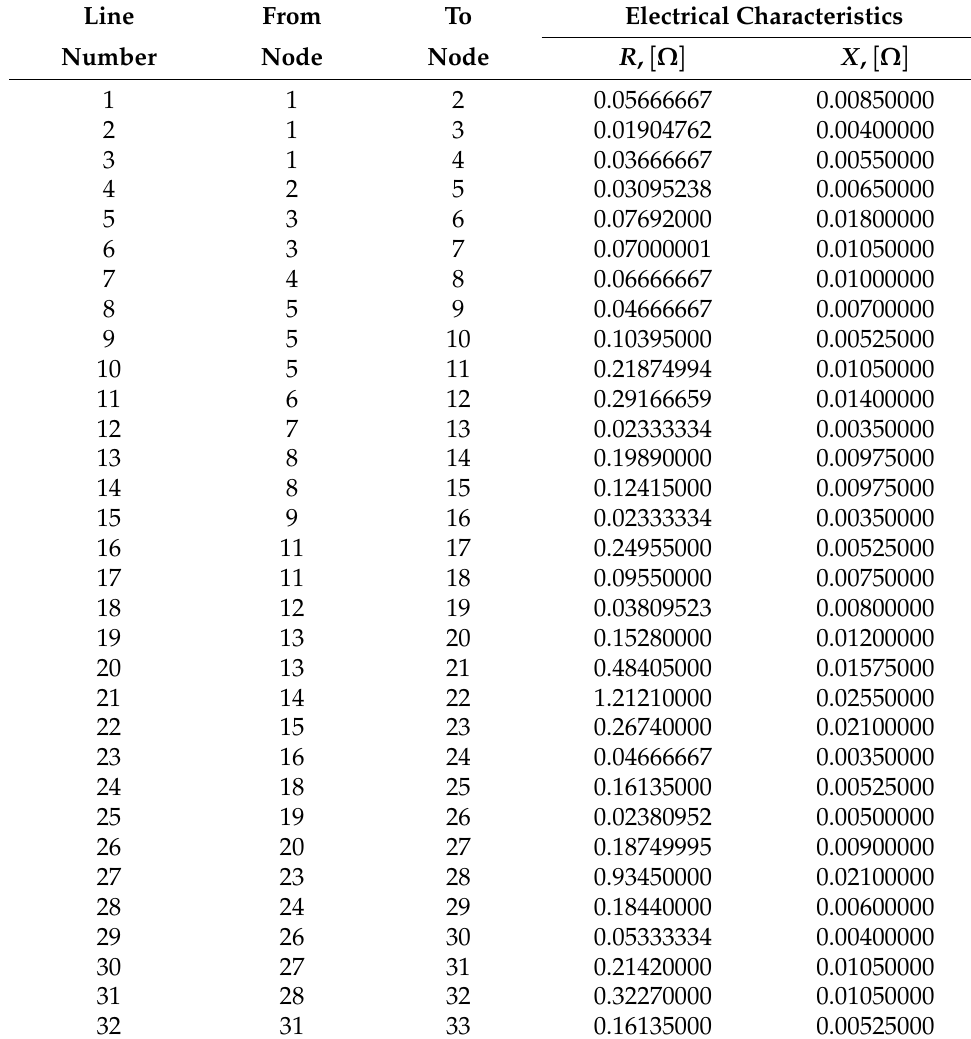
Table A2. Cluster 02. Baseline LV network characterization and electrical